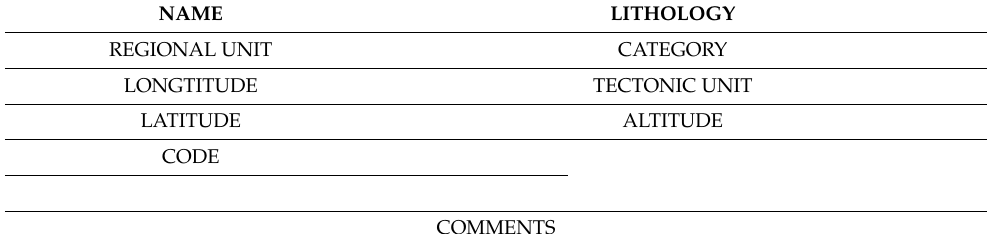
Table 2. Standard protocol for recording geosite characteristics